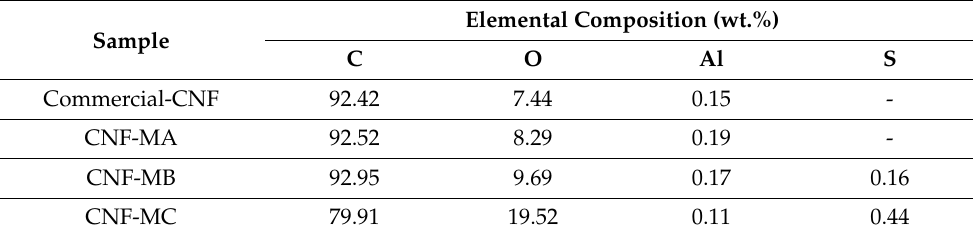
Table 5. EDX chemical composition of representative CNFs samples.